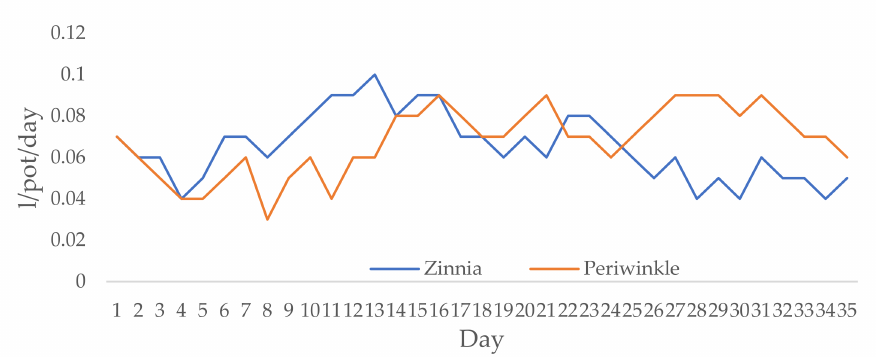
Figure 1. Irrigation rates (L/pot/day) for zinnia and